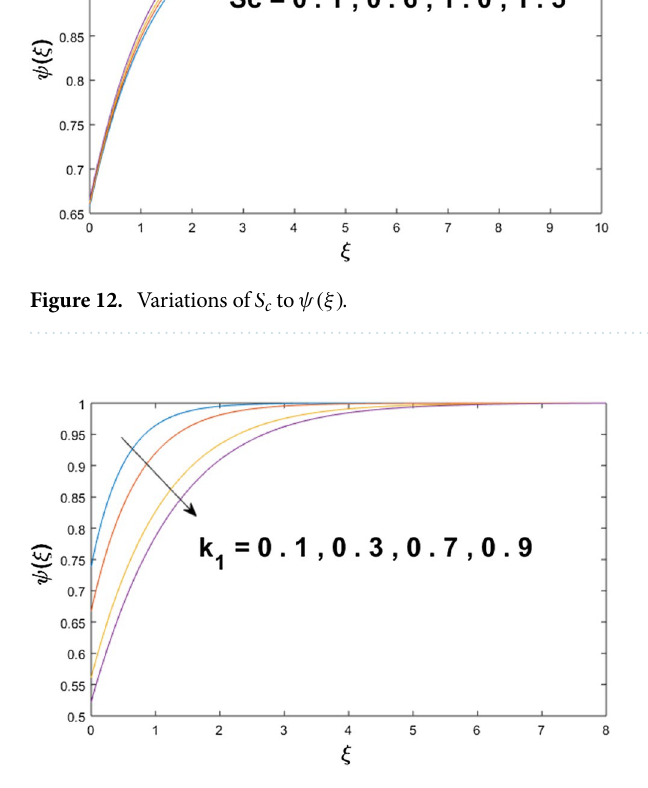
Figure 13. Variations of k 1 to ψ(ξ) .